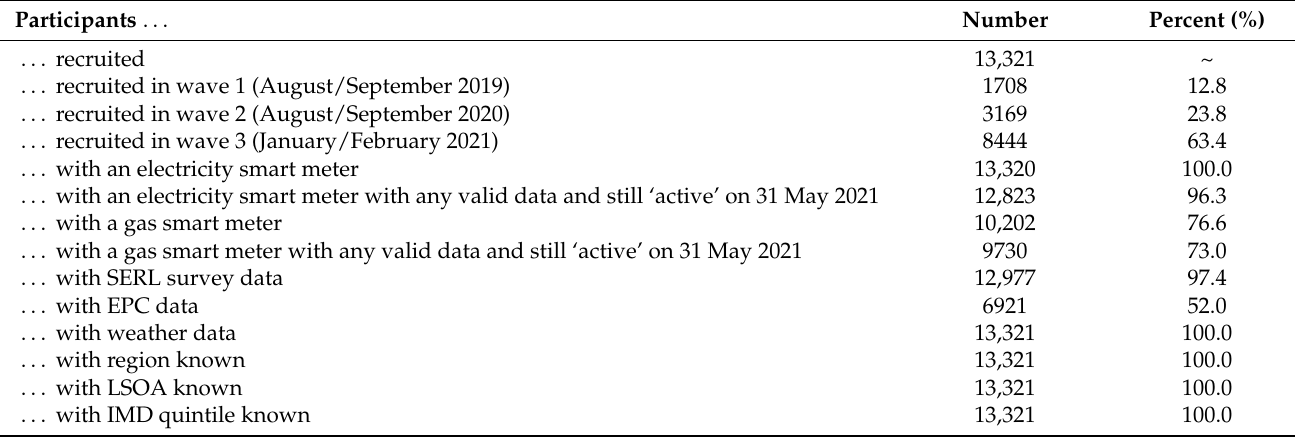
Table 1. Number and percent of participants in the SERL Observatory with different types of data. By ‘active’ we mean that they have not withdrawn consent or moved house (i.e., data collection remains ongoing). Note that we do not include participants who were recruited but withdrew consent too soon for smart meter data collection to begin, or for whom smart meter data collection is not possible for technical reasons.